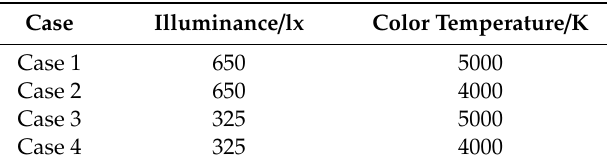
Table 1. Illumination environments.